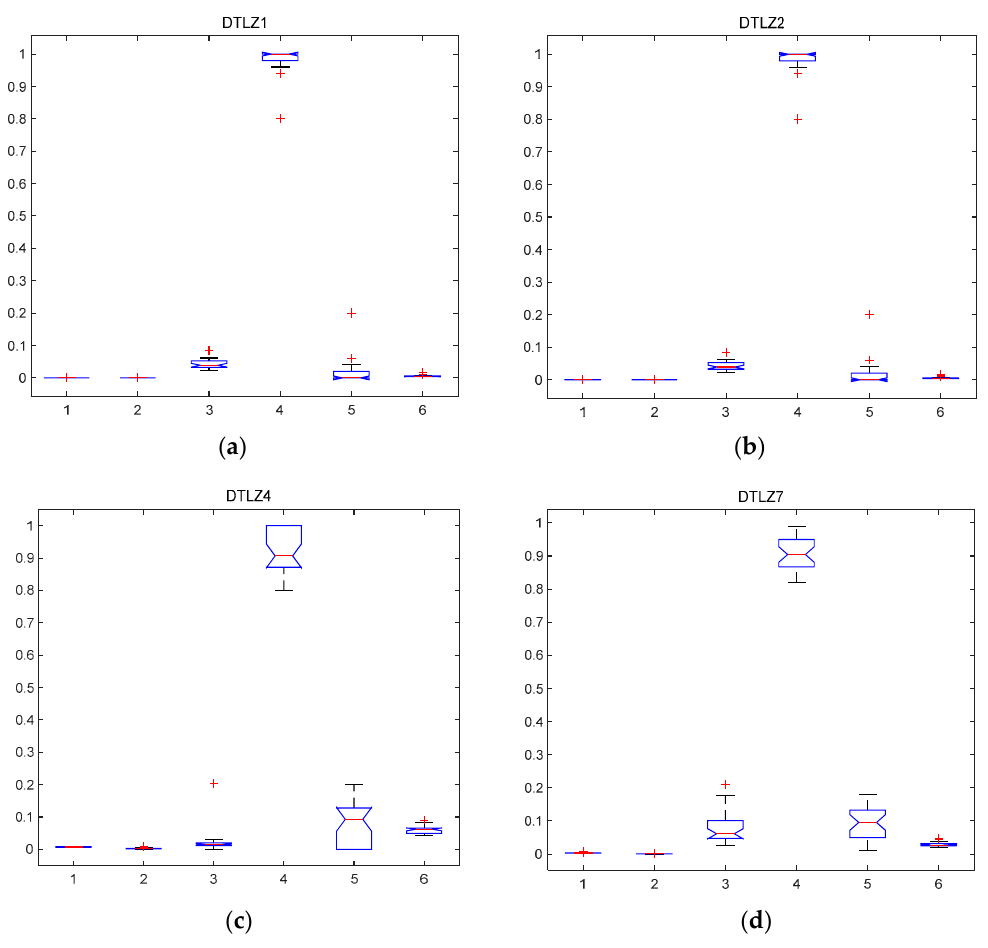
( d ) Figure 1. Box plot representing the distribution of the metrics on ZDT test problems (GD = 1, standard deviation of GD = 2, SP = 3, CR = 4, ER = 5 and γ = 6). ( a ) the metrics on ZDT1 problem; ( b ) the metrics on ZDT2 problem; ( c ) the metrics on ZDT3 problem; ( d ) the metrics on ZDT4 problem.